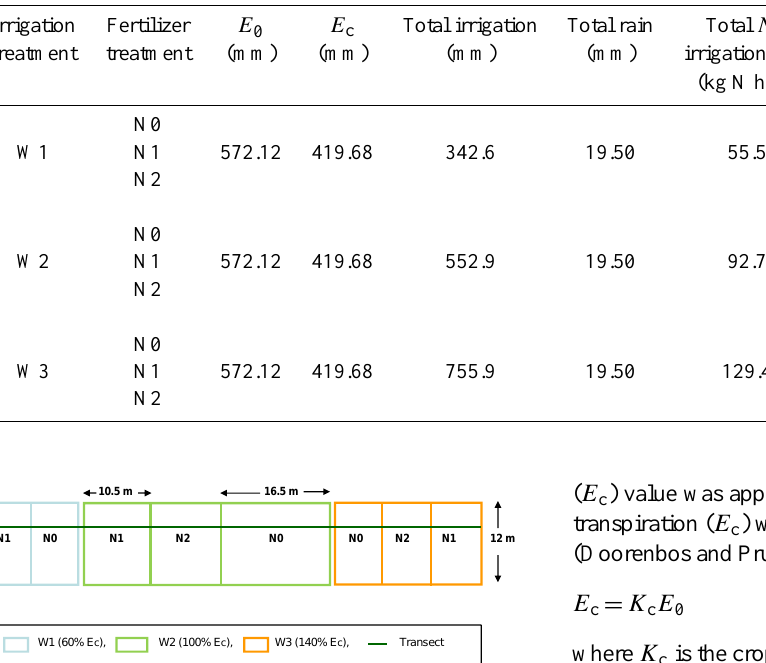
Table 1. The treatments applied to the melon crop, reference evapotranspiration E 0 (15 to 104 DAT) and estimated crop evapotranspiration E c values (15 to 104 DAT), total irrigation (applied irrigation, taking initial establishment irrigation into account, in the different treatments: